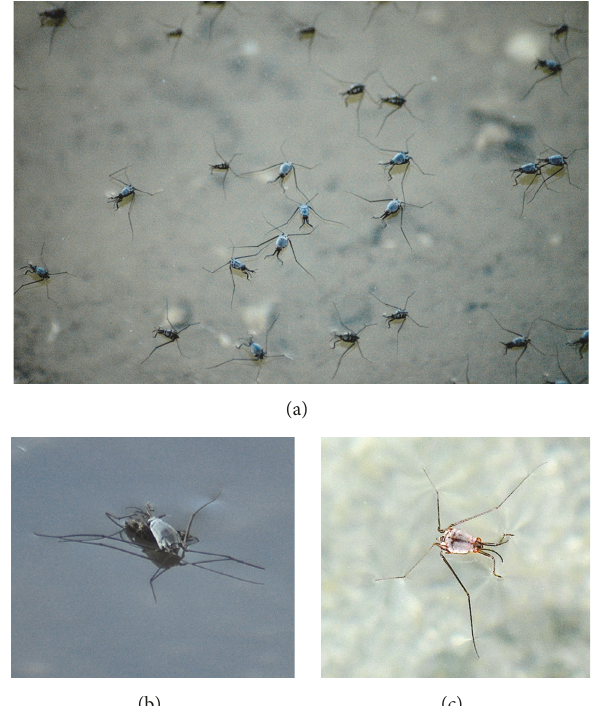
Figure 1: (a) Aggregation of sea skaters (photo by Y. Nozoe). (b) Adult of H. matsumurai (photo by N. Nishimura). (c) Adult of A. shiranui (photo by Y.